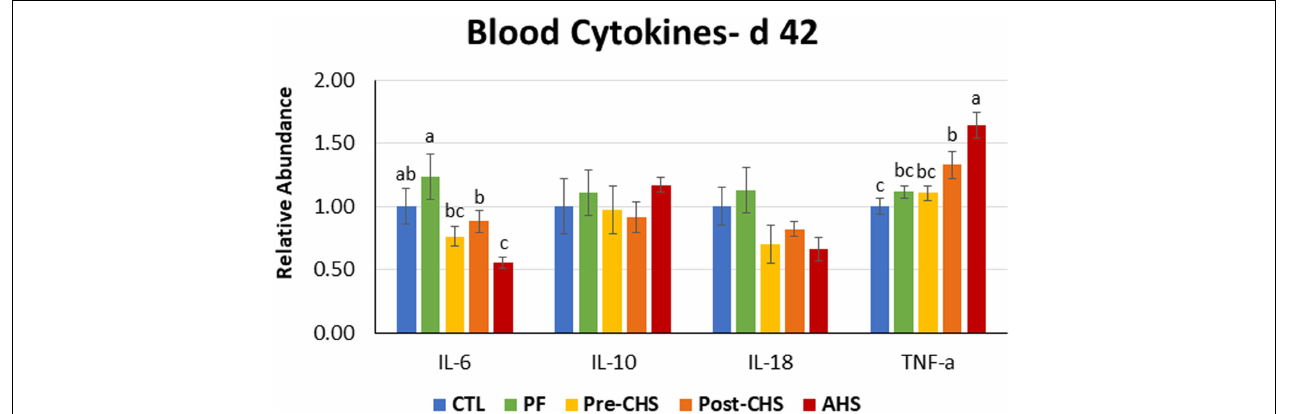
FIGURE 6 | Relative mRNA abundance of interleukin ( IL )- 6 , IL10 , IL18 , and tumor necrosis factor- α in the blood of Cobb 500 male broiler chickens on day 42. Birds in all the groups were raised under the recommended conditions from day 0 to 28. Treatments include: (1) control (CTL): birds raised under thermoneutral condition (23 ◦ C) from day 29 to 42; (2) AHS: birds raised under thermoneutral condition (23 ◦ C) from day 29 to 42, but exposed to 2 h AHS (35 ◦ C) before sampling on day 42; (3) Pre-CHS: birds exposed to high ambient temperature (35 ◦ C) for 8 h/day (9:30 am–5:30 pm) from day 29 to 42, and sampled before starting the CHS; (4) Post-CHS: birds exposed to high ambient temperature (35 ◦ C) for 8 h/day (9:30 am–5:30 pm) from day 29 to 42, and sampled 2 h after starting the CHS; (5) pair-fed (PF): birds raised under thermoneutral condition (23 ◦ C) from day 29 to 42, but pair-fed to CHS group (these birds received each day 1.05 times the average feed intake recorded in the CHS group in the previous day). Values are represented as a n -fold difference relative to the calibrator (CTL). Results are given as means ( n = 8) for each group. Error bars indicate standard errors. For each gene, bars with different letters are significantly different ( P < 0.05).